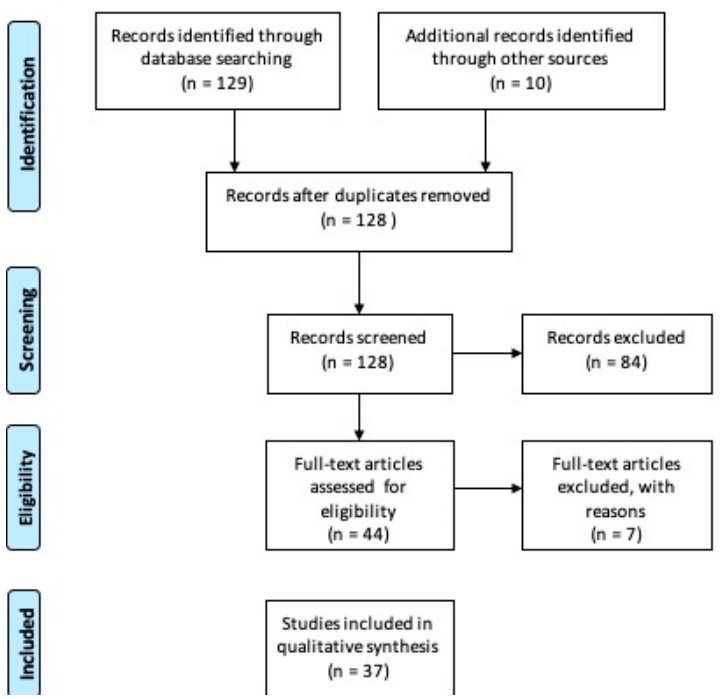
Figure 1. Preferred Reporting Items for Systematic Reviews and Meta-Analysis (PRISMA) on saliva proteomics data in immune mediated and inflammatory skin diseases. Research dates range from 1994 to 2020 [25].